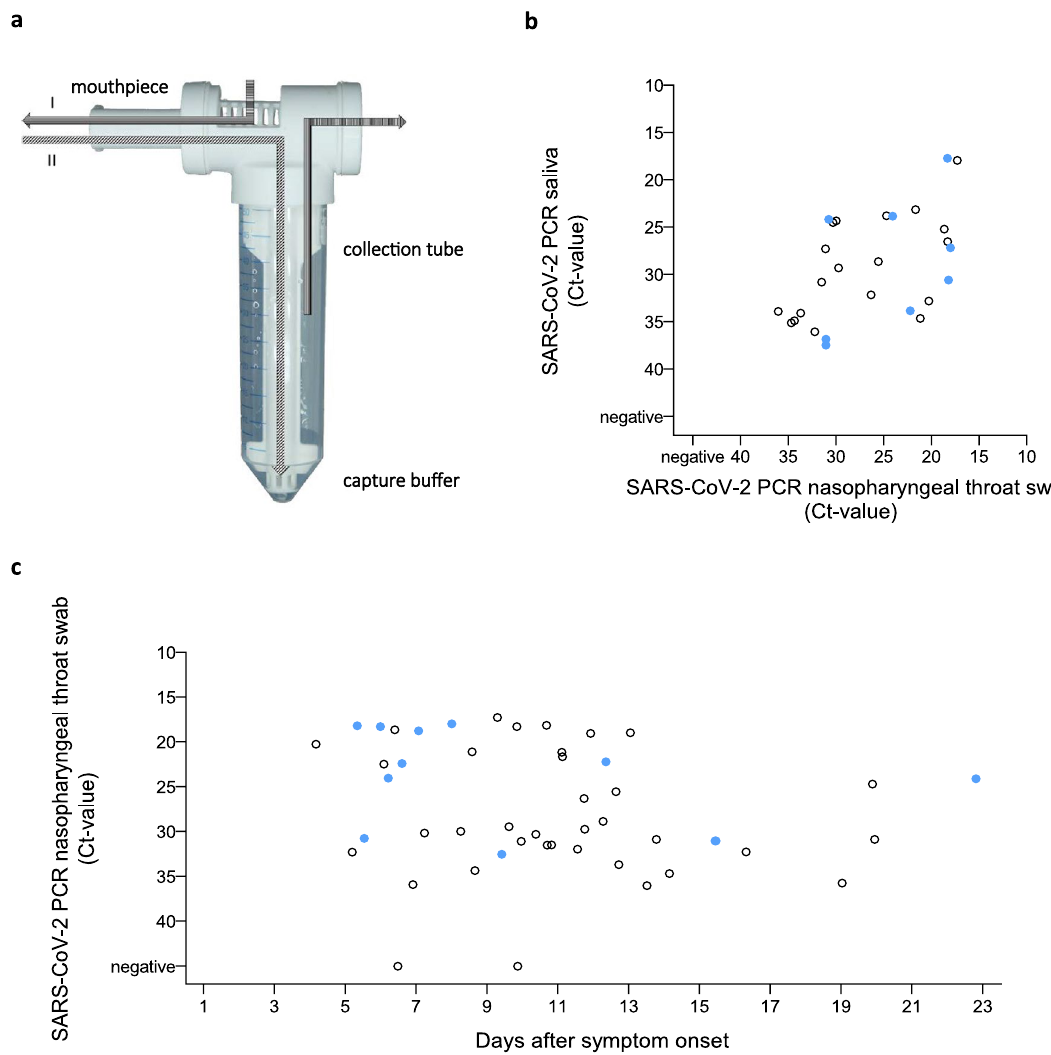
Figure 1. ( a ) Modular breath sampler. During sampling, the patient breathes through the mouthpiece; inhaling (I) and exhaling (II). The exhaled air is guided through the sampler to the diffuser into the capture buffer. The exhaled air leaves the sampler on the back end. After sampling, the collection tube can be disconnected and stored for analysis. ( b ) Correlation plot depicting SARS-CoV-2 viral RNA load measured in nasopharyngeal throat swab and saliva samples. ( c ) SARS-CoV-2 RNA detection in exhaled air samples and nasopharyngeal throat swab samples. Filled dots ( ) represent cases in which SARS-CoV-2 RNA was detected in exhaled air samples. Open dots ( ○ ) represent cases in which SARS-CoV-2 RNA was not